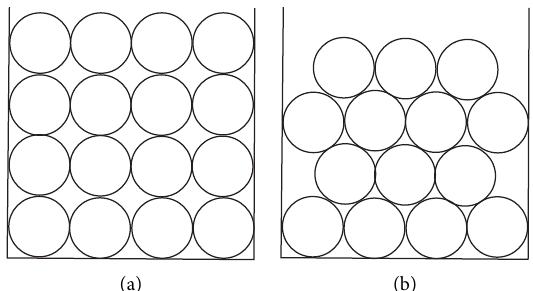
Figure 2: How to place uniform granulation after precipitation considering spherical grains of the same size. (a) Placement of materials with a high probability of occurrence after falling. (b) Placement of materials with low probability of occurrence and after shedding [10].